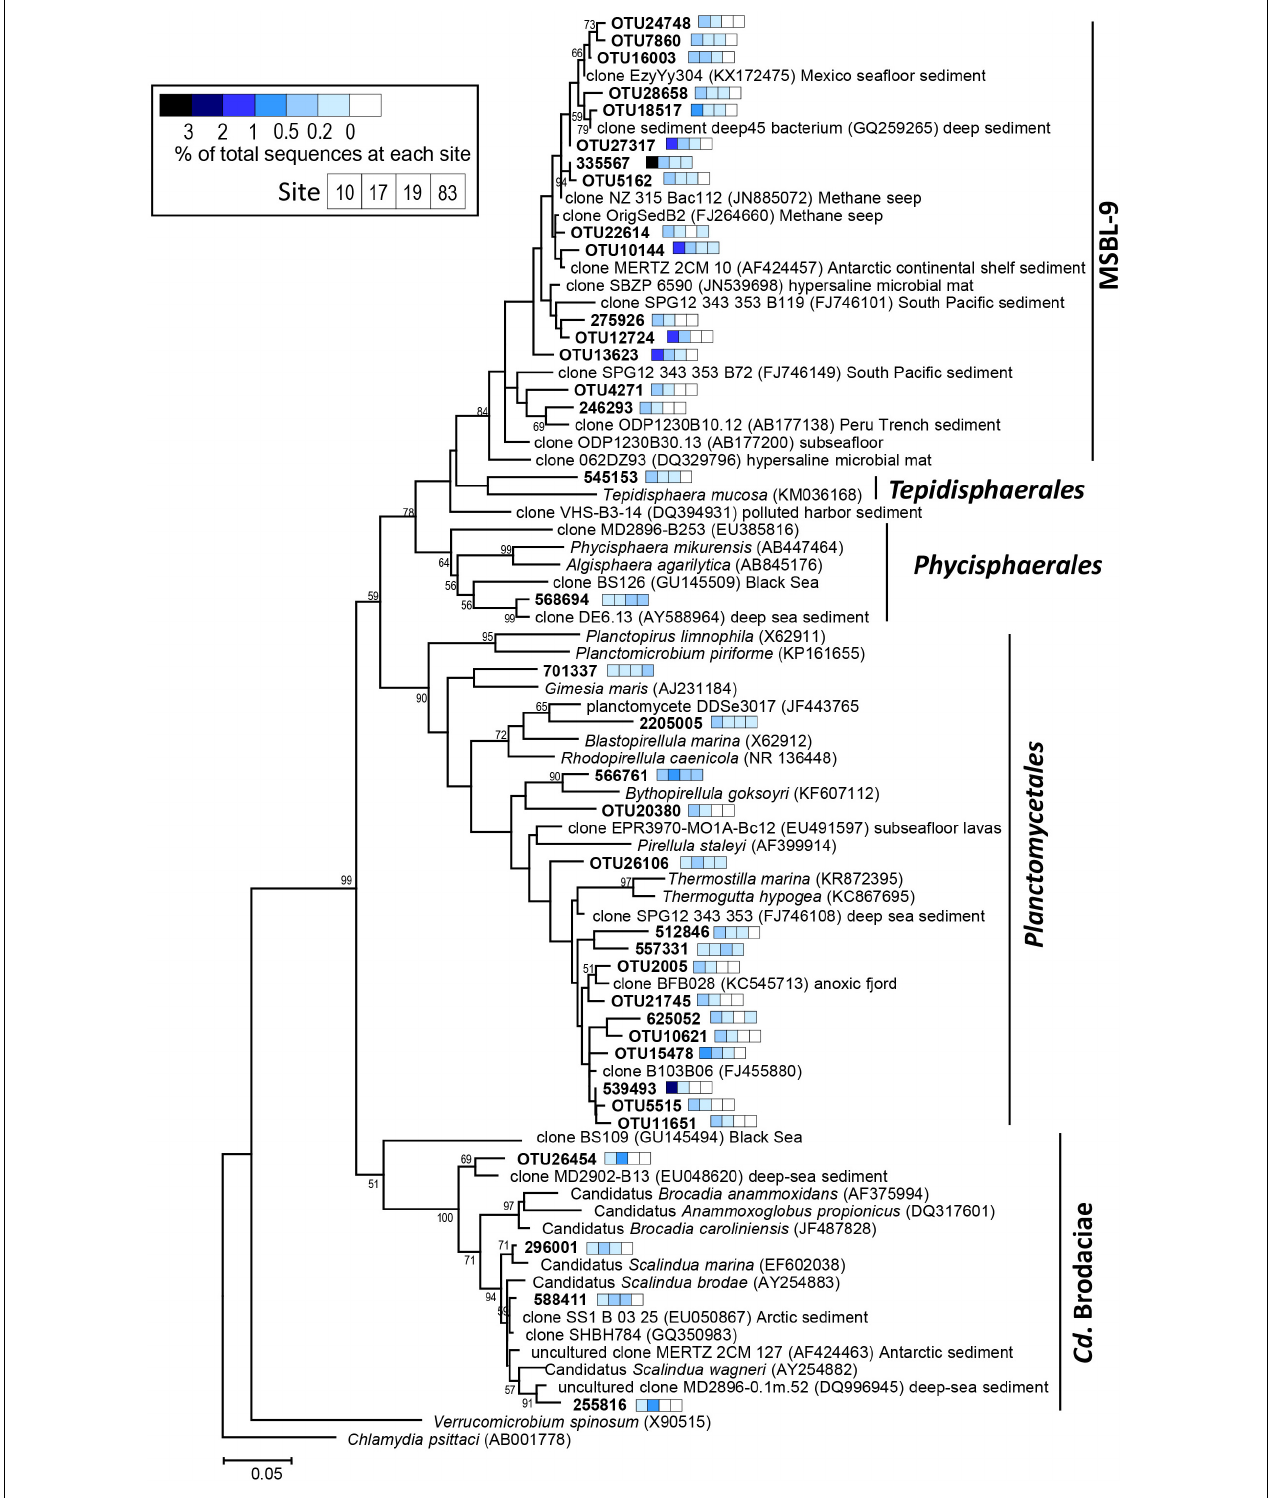
FIGURE 5 | Phylogenetic tree showing the distribution of the 16S rRNA genes sequences retrieved from the ASP sediments within the phylum Planctomycetes . The tree was constructed using the maximum-likelihood algorithm in MEGA 7.0 (Kumar et al., 2016). The scale bar indicates the number of substitutions per nucleotide position. The color of the square bar represents the relative abundance of the sequences for each site (Stn 10, Stn 17, Stn 19, and Stn 83). Node support estimated using 1,000 bootstrap replicates. Bootstrap values above 50% are shown.